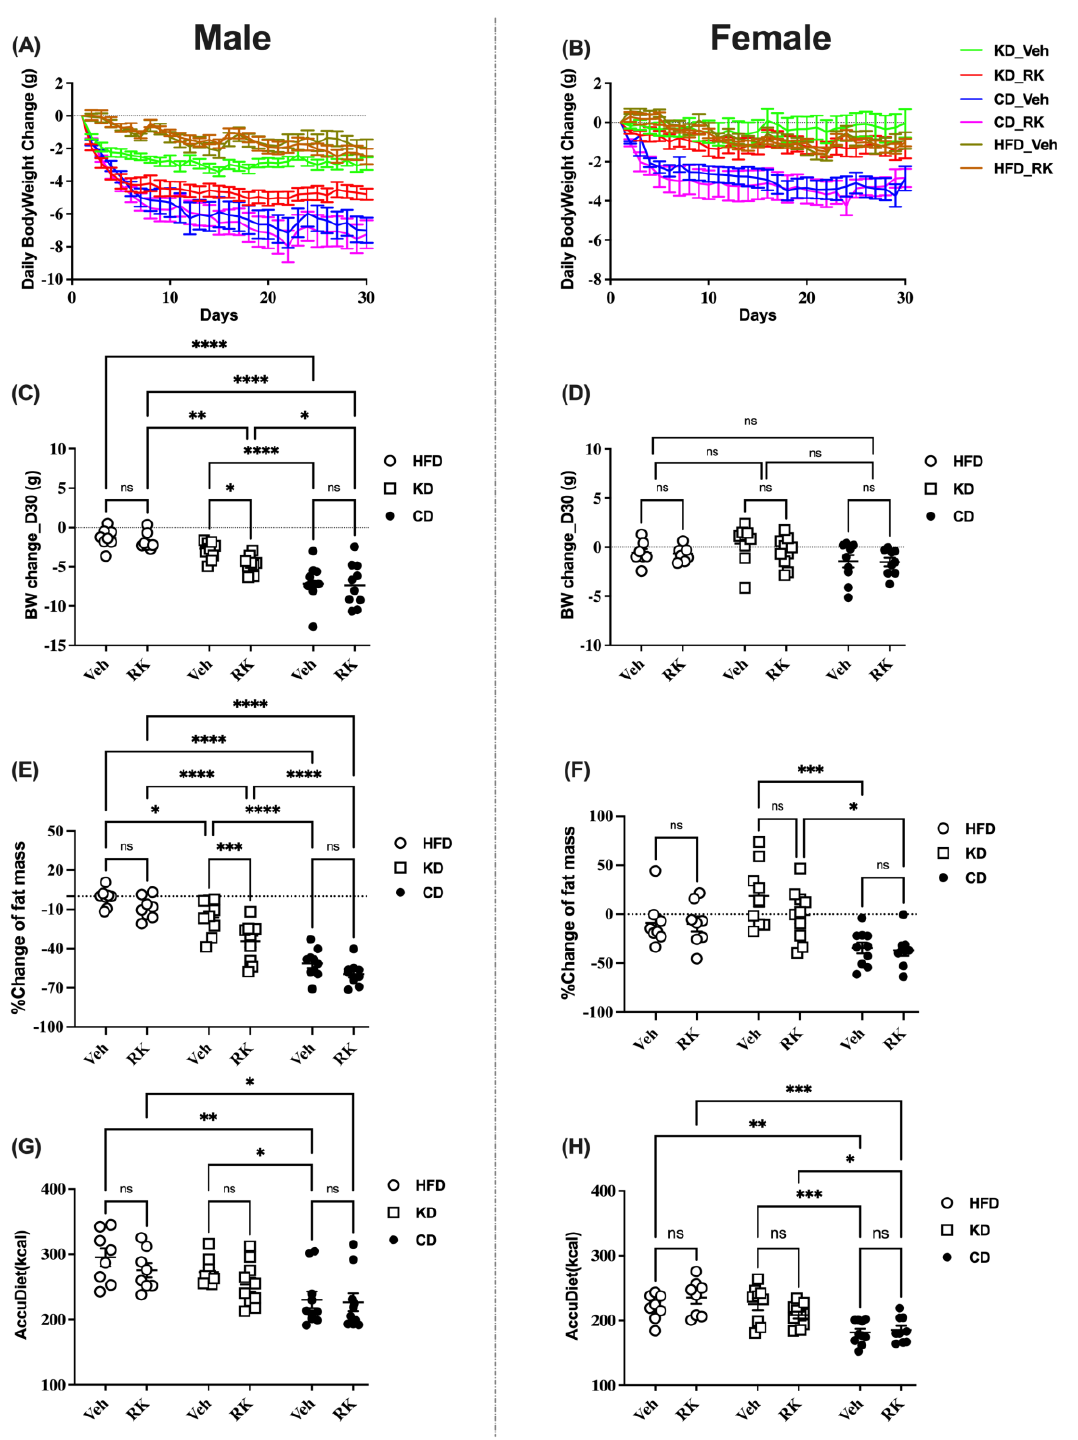
Figure 1. Daily body weight change during daily dosing and diet feeding ( A , B ), changes of body weight ( C , D ) and body fat ( E , F )and accumulated calories intake ( G , H ) in overweight/obese male and female mice after 4 weeks of daily dosing and diet feeding. Data are represented as mean ± standard error of the mean (SEM). * p < 0.05; ** p < 0.01; *** p < 0.001; **** p < 0.0001; ns, not significant. Two-way analysis of variance (ANOVA) followed by Newman-Keuls post hoc tests when justified; p < 0.05 was considered statistically significant. N = 8-10 mice/group. High-fat diet (45%fat), HFD; ketogenic diet (80%fat), KD; control diet (10%fat), CD; vehicle, Veh; raspberry ketone, RK; accumulated diet, AccuDiet; day, D.